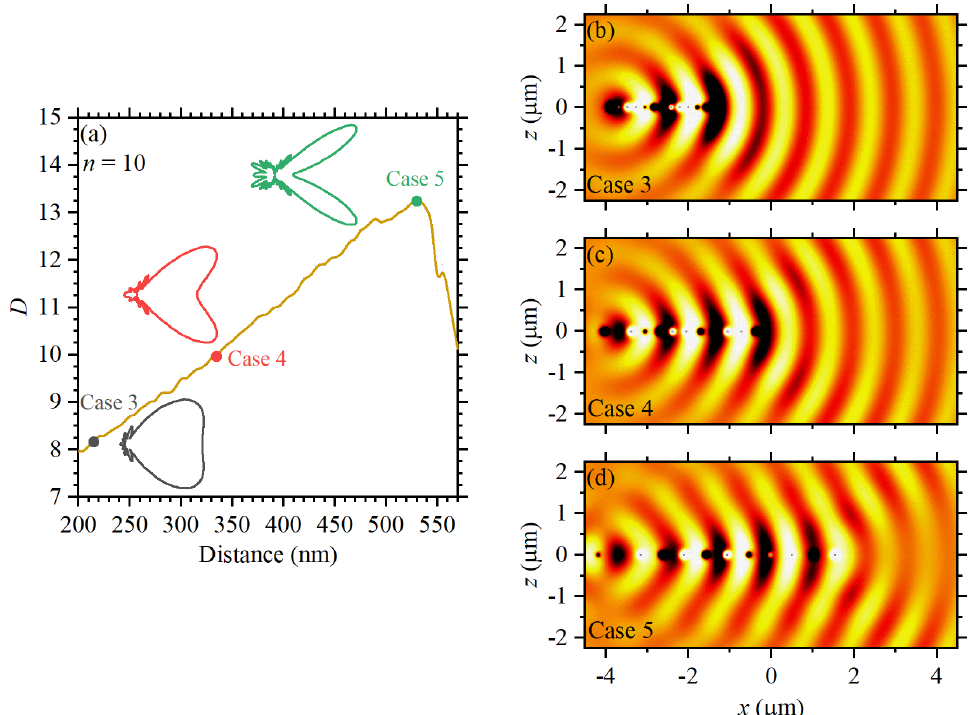
Figure 8. ( a ) Directivity as a function of the inter-particle distances for Cases 3 to 5 corresponding to n = 10. ( b – d ) Show the corresponding scattered fields (around the structure) for each